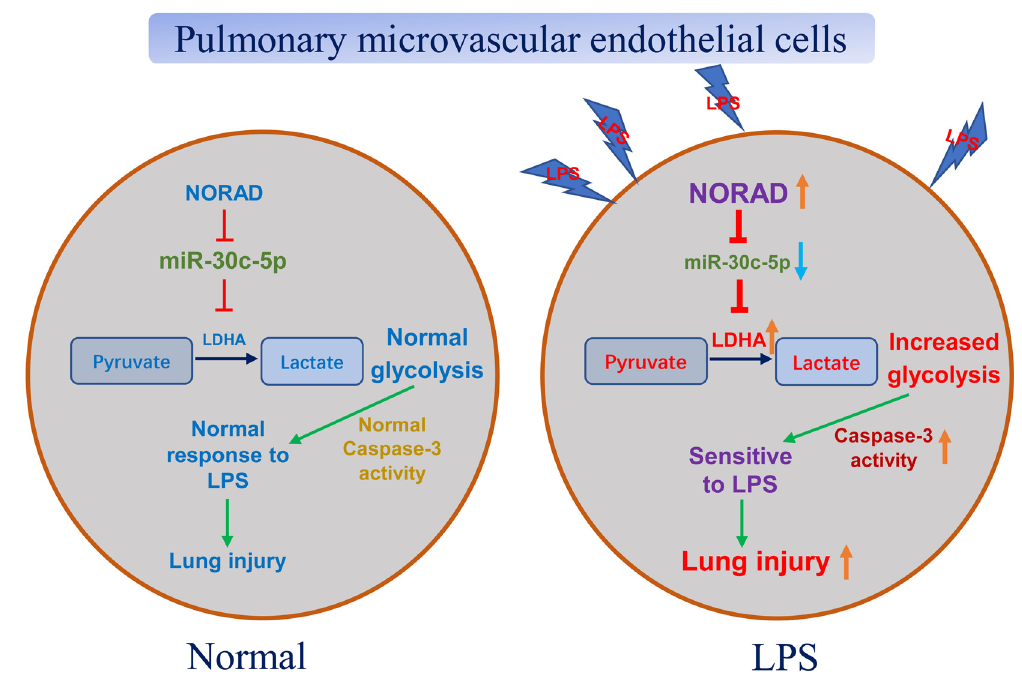
Figure 9: A working model for the NORAD - miR - 30c - 5p - LDHA axis in the LPS - induced HPMECs